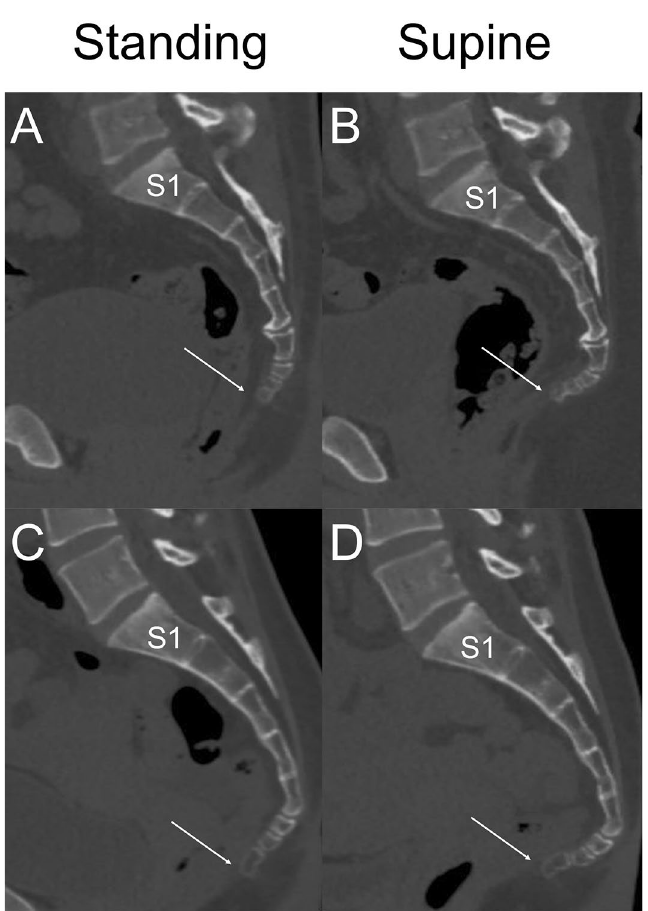
Figure 2. Computed tomography imaging of the coccyx in healthy volunteers. The coccyx of a 36-year-old man in the standing position ( A ) and the supine position ( B ), and the coccyx of a 47-year-old parous woman in the standing position ( C ) and supine position ( D ) in the mid-sagittal plane. As demonstrated, the coccyx becomes longer and straighter, with the tip of the coccyx (white arrow) moving backward and downward relative to the supine